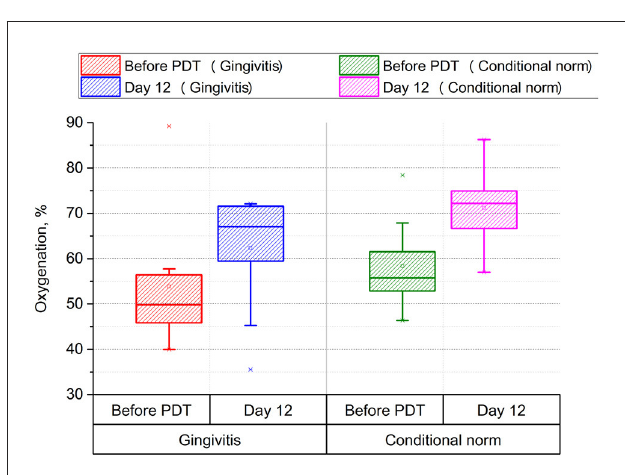
FIGURE3 Assessment of the level of gingival tissue oxygenation before and after photodynamic therapy ( p < 0.001, power >